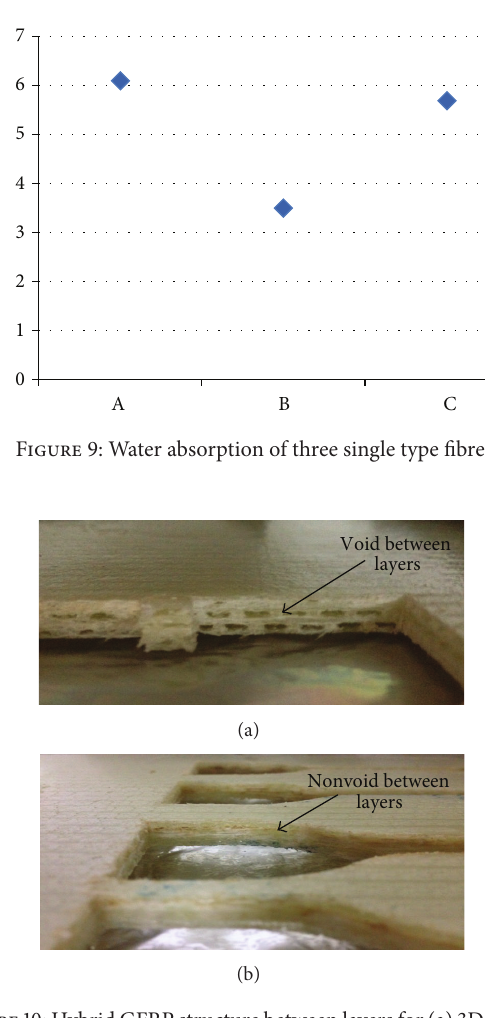
Figure 10: Hybrid GFRP structure between layers for (a) 3D and (b)